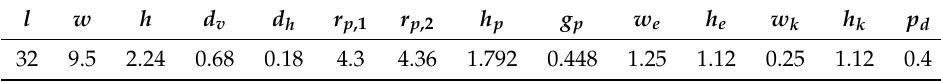
Figure 8. ( a ) Three-pole BPF filter layout; ( b ) Simulated frequency response. Table 3. Layout Dimensions of the Three-Pole CSIW Filter (Unit: